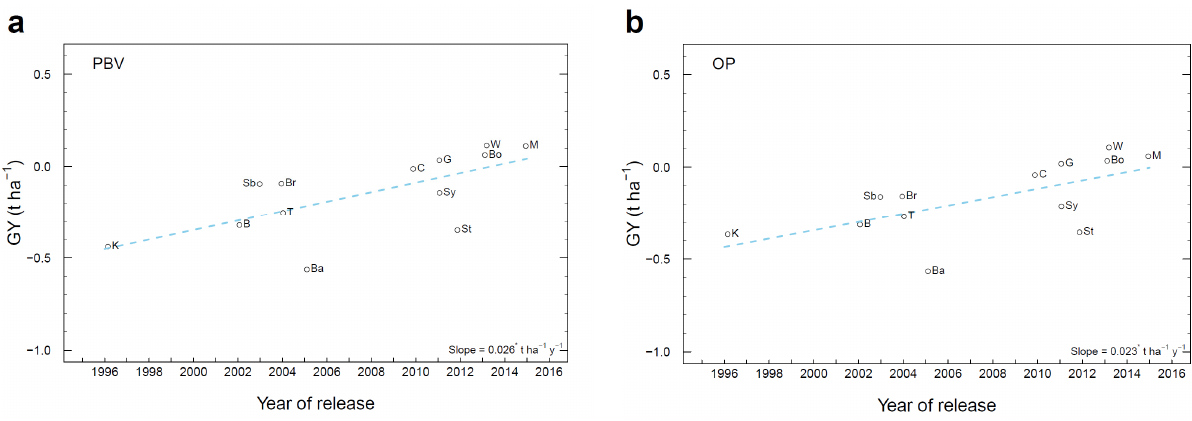
Figure 9. Genetic gain per year for grain yield (GY, t ha -1 ) in historical cultivars in the trials, based on the slope of the linear regression across year of release expressed in t ha -1 y -1 of ( a ) PBV for GY averaged across environments where the mean standard error of cultivars was 0.133 t ha -1 , and ( b ) OP for GY. PBV and OP were obtained from the optimum MMM-FA model of the genotype × environment interaction effects. Significance of the slope of the linear regressions: * p < 0.05. Abbreviations of historical cultivars and year of release: K (Karoo, 1996), B (ATR Beacon, 2002), Sb (ATR Stubby, 2003), Br (Bravo TT, 2004), T (Tornado TT, 2004), Ba (Banjo TT, 2005), C (Crusher TT, 2010), G (ATR Gem, 2011), Sy (ATR Stingray, 2011), St (Sturt T, 2012), A (ATR Wahoo, 2013), Bo (ATR Bonito, 2013), and M (ATR Mako, 2015).